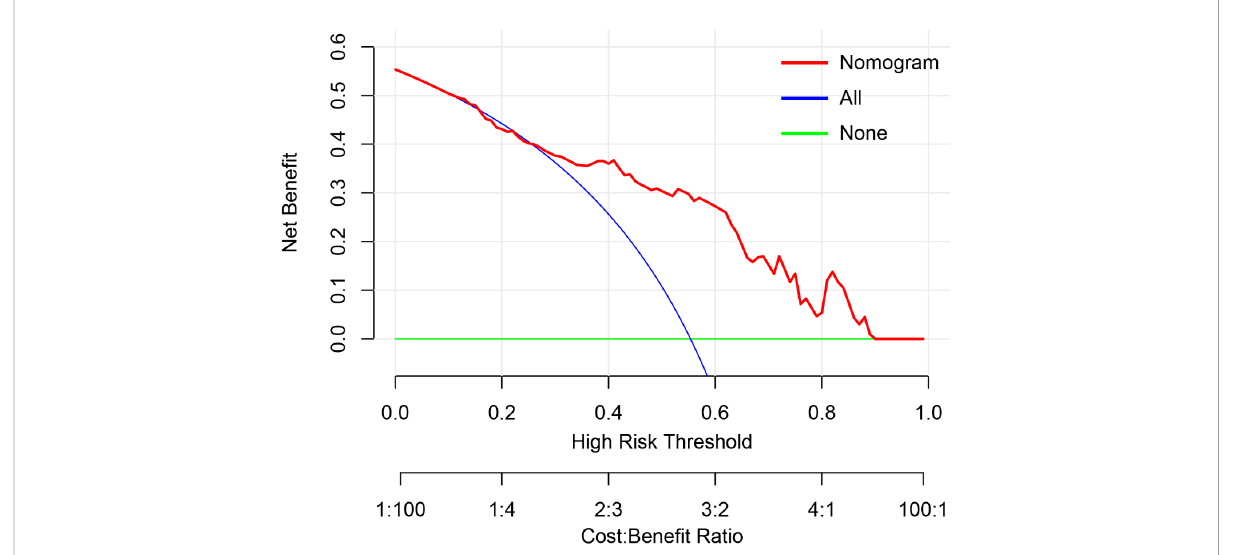
FIGURE 7 The decision curve analysis of nomogram in validation cohort. The y-axis measures the net bene fi t. The red line represents the developed nomogram. The blue line represents the assumption that all patients are presented with lymphovascular invasion (LVI). The green line represents the assumption that no patients are presented with LVI. The net bene fi t was calculated by subtracting the proportion of all patients who are false positive from the proportion who are true positive, weighting by the relative harm of forgoing treatment compared with the negative ), “ pt ” (threshold probability) is where the expected consequences of an unnecessary treatment. Here, the relative harm was calculated by. ( pt 1 − pt bene fi t of treatment is equal to the expected bene fi t of avoiding treatment; at which time a patient will opt for treatment informs us of how a patient weighs the relative harms of false-positive results and false-negative results. a − c b − d ) = 1 − pt pt ); a − c is the harm from a false-negative result; b − d is the harm from a false positive result. a, b, c and d give, respectively, the value of true positive, false positive, false negative, and true negative (23) The nomogram exhibited higher net bene fi t in predicting LVI positive status across the range of threshold probabilities from 0.22 to 0.90 than the treat-none and treat-all